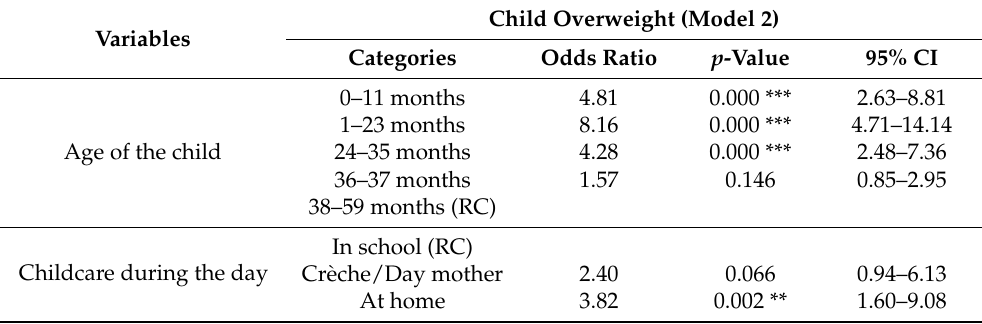
Table 6. Multivariable analysis of risk factors associated with child overweight among children under